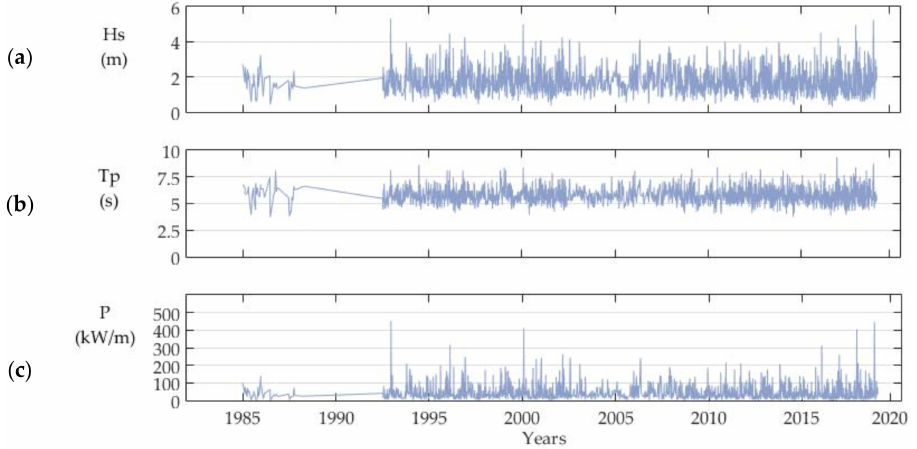
Figure 4. Hydrodynamic conditions during the analysed period: ( a ) H s (m), ( b ) T p (s), and ( c ) P (kW/m). Tropical cyclones track data were obtained from a database from the Australian Bureau of Meteorology (BOM) (http://www.bom.gov.au/cyclone/history/) and were categorized (from 1 to 5) according to their wind speeds (maximum mean wind speeds of 63–88, 89–117, 118–159, 160–199, and above 200 km/h, corresponding to Categories 1, 2, 3, 4, and 5, respectively). A total number of 118 cyclones were tracked in the Great Barrier Reef (GBR) from 1964 to 2019; however, only 109 were analyzed as the remaining nine